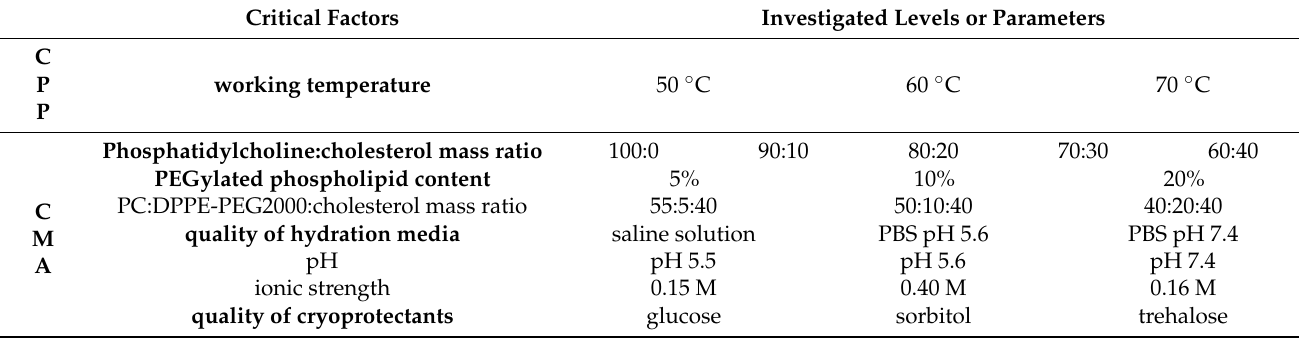
Table 4. Critical factors and their levels investigated in the liposome formulation